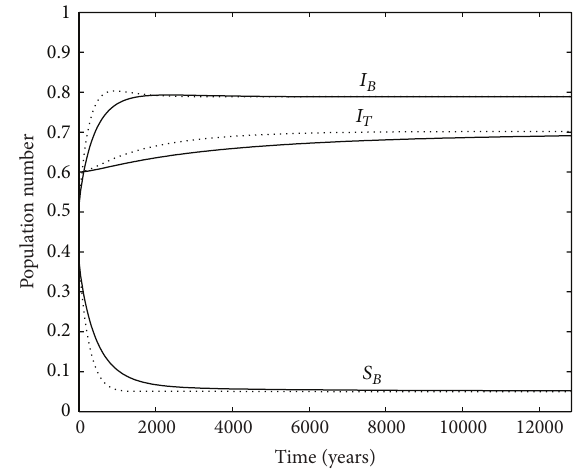
Figure 2: Dynamic of the bovine babesiosis disease, with 𝜃 = 1 (continuous line) and 𝜃 = 0 . 9 (dotted